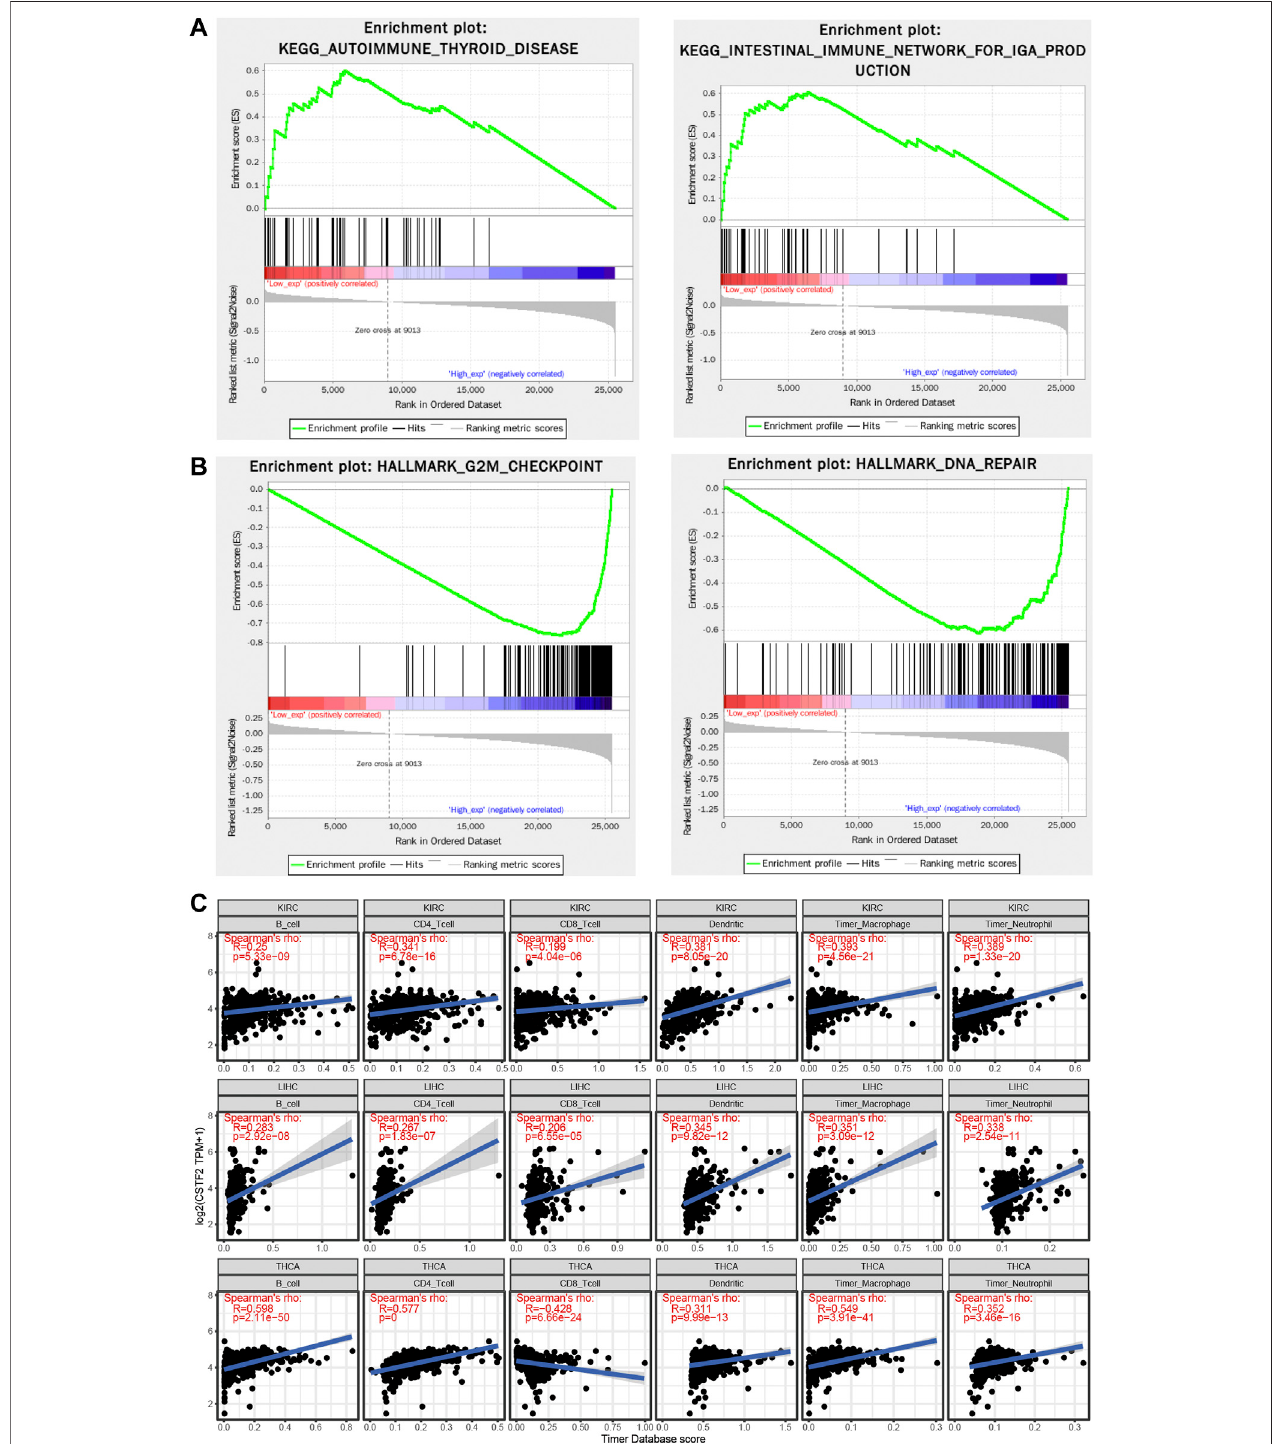
FIGURE 5 | CSTF2 is associated with immunoin fi ltration in the pan-cancer analyses. (A,B) Gene set enrichment analysis of CSTF2 to seek key signaling pathway and hallmark. (C) Immunoin fi ltration of CSTF2 in different cancers.